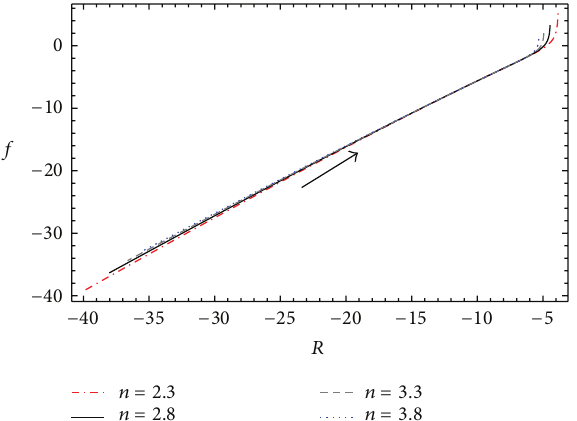
Figure5:Futureevolutionof 𝑓(𝑅) fordifferentvaluesof 𝑛 with −1 ≲ 𝑧 ⩽ 2 .